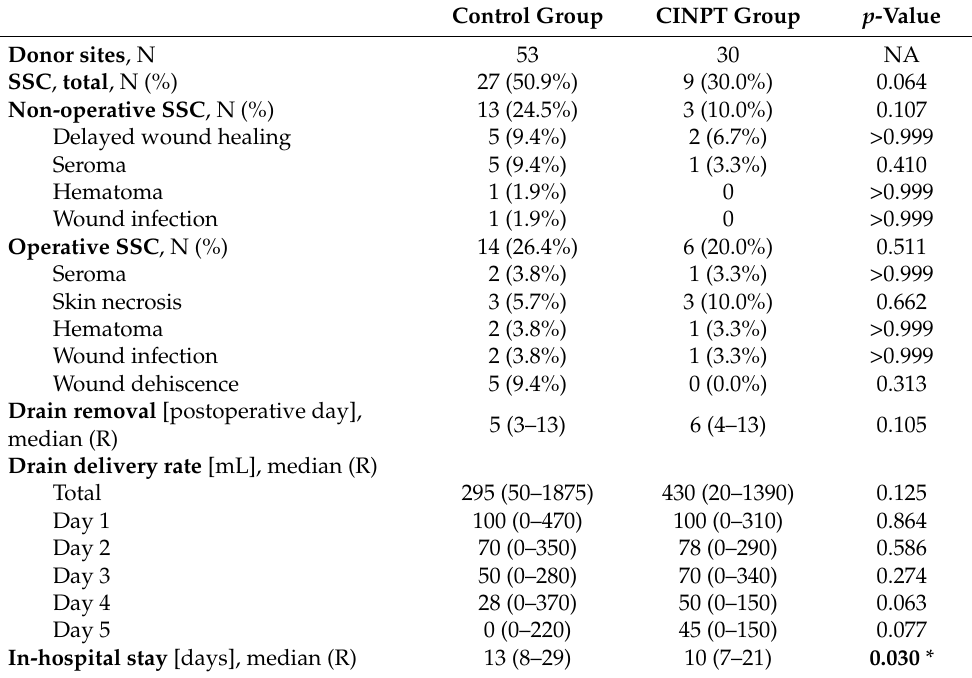
Table 3. Postoperative